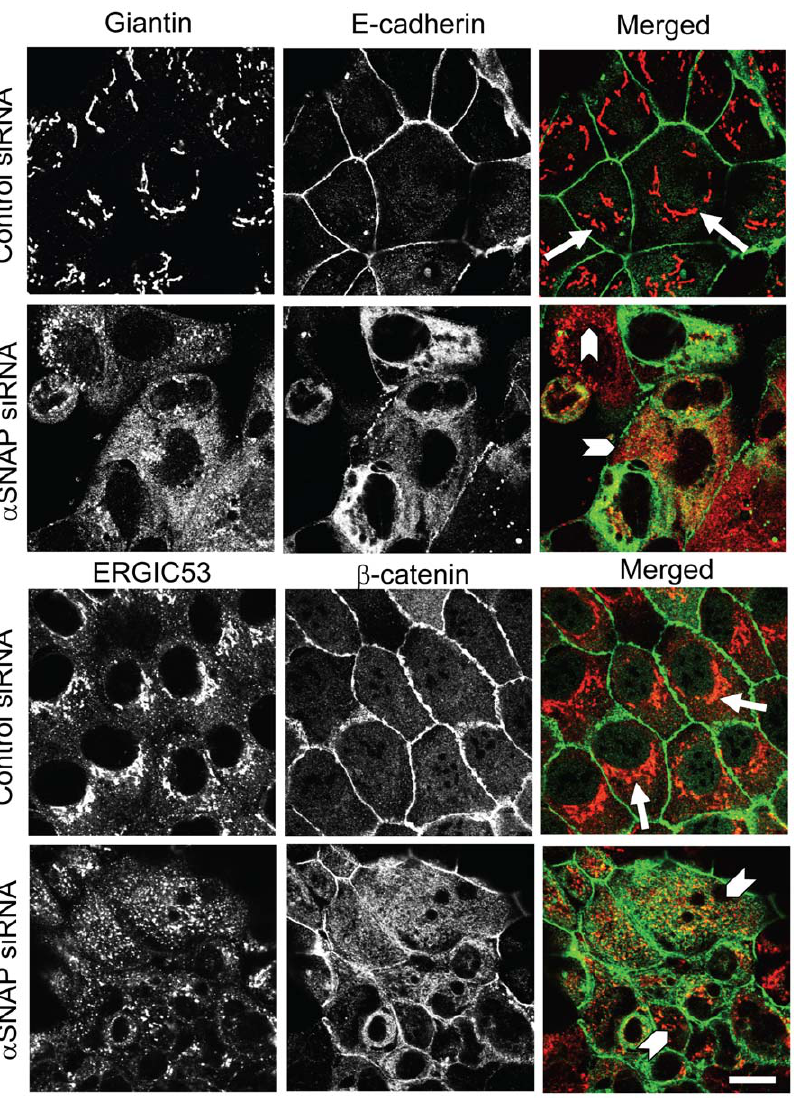
Figure 7. a SNAP depletion induces fragmentation of the Golgi and ERGIC. Control and a SNAP-depleted SK-CO15 cells were immunofluorescence labeled for b -catenin (green) with either Golgi marker GM130, or ERGIC marker ERGIC53 (red) on day 3 post-transfection. Control cells show perinuclear tubular Golgi complexes and well-organized compact ERGIC (arrows). By contrast, a SNAP depletion results in a dramatic dispersion of both perinuclear Golgi and ERGIC structures (arrowheads). Scale bar, 10 m m.